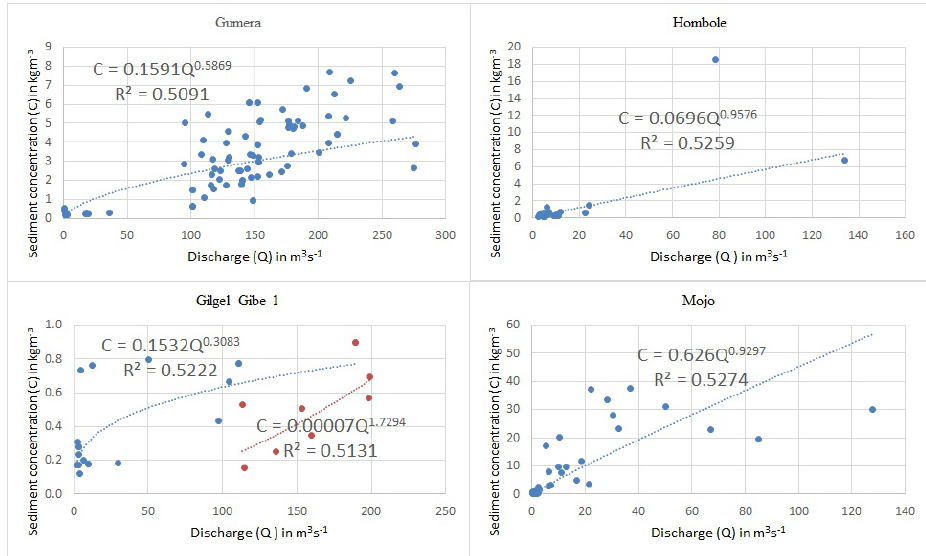
Figure 17. Sedimentrating curves for each watershed under our